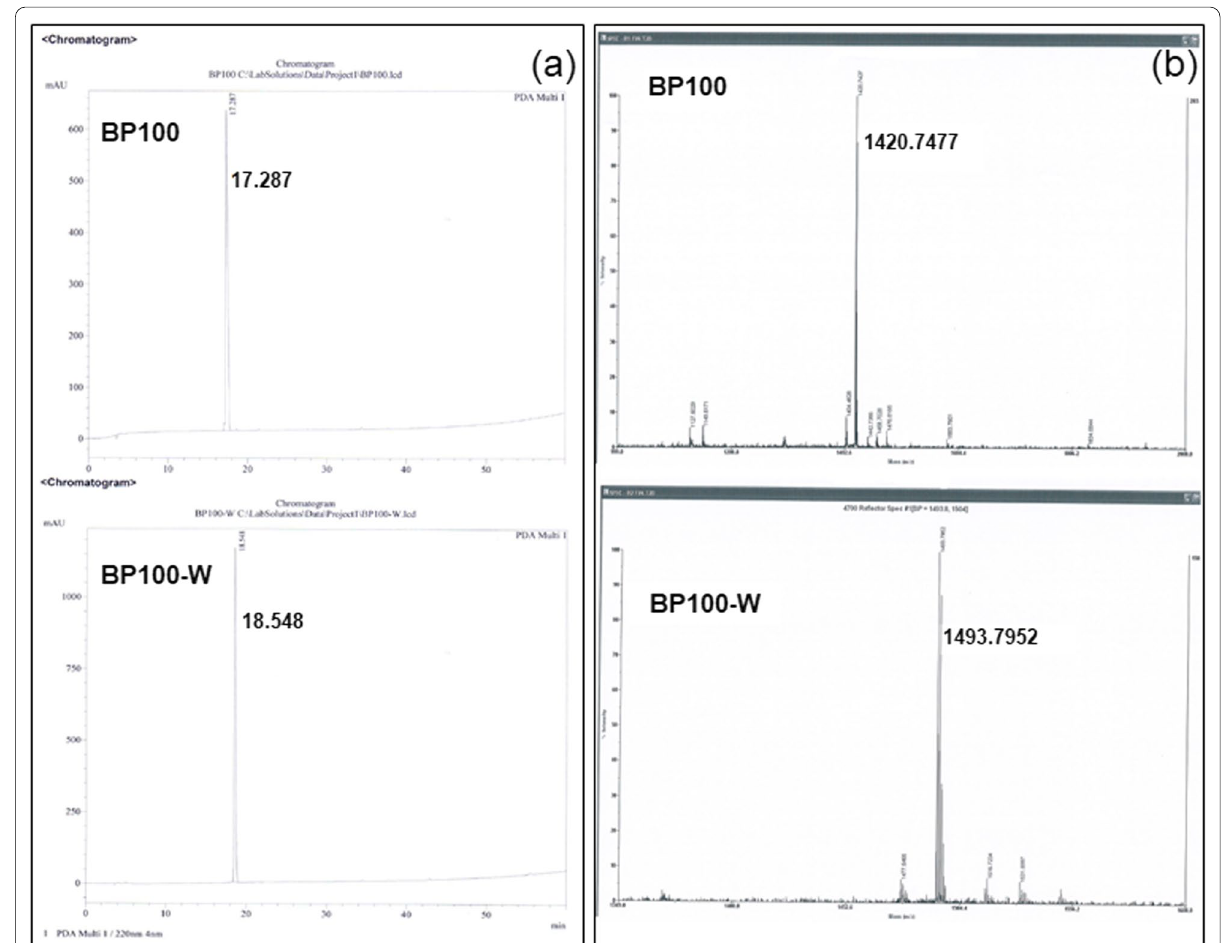
Fig. 2 a Reverse phase high-performance liquid chromatography (RP-HPLC) analysis of BP100 and BP100-W. b Matrix-assisted laser desorption/ ionization-time-of-flight-mass spectrometry (MALDI-TOF–MS) for BP100 and BP100-W